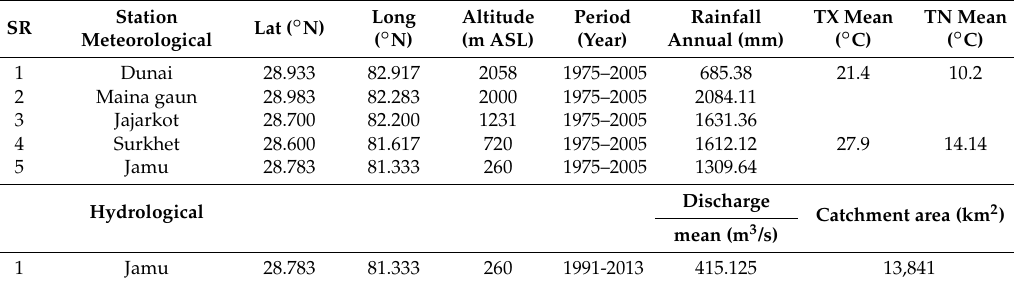
Table 1. Basic information about hydro-climatic station in the Bheri river basin.